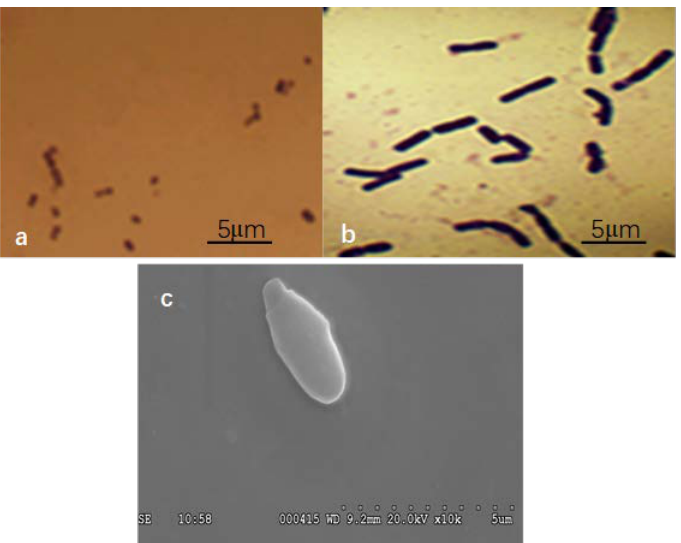
Figure 1. The morphology of Smobiisys501 under a microscope. ( a ): Cell morphology of Smobiisys501 under an optical microscope (10 × 100) in acid medium (pH = 6); ( b ): Cell morphology of Smobiisys501 under an optical microscope (10 × 100) in alkaline medium (pH = 9); ( c ): Cell morphology of Smobiisys501 under an electron microscope (2 000 × 10).